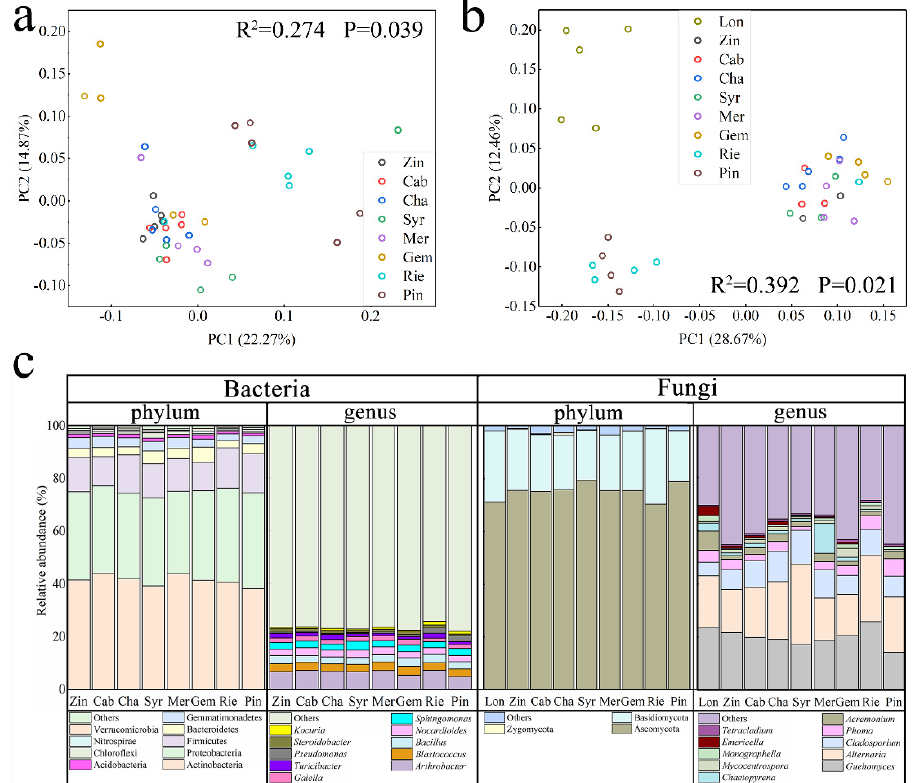
Figure 2. Principal coordinates analysis (PCoA) of the variation in bacteria ( a ) and fungi ( b ) commu- nity structures of nine types of wine grape rhizosphere. Relative abundance of bacteria and fungi associated with phylum and genus ( c ). Zinfandel (Zin), Cabernet Sauvignon (Cab), Syrah (Syr), Mer- lot (Mer), Gem (Gem), Pinot noir (Pin), Riesling (Rie), Longan (Lon), Chardonnay (Cha).